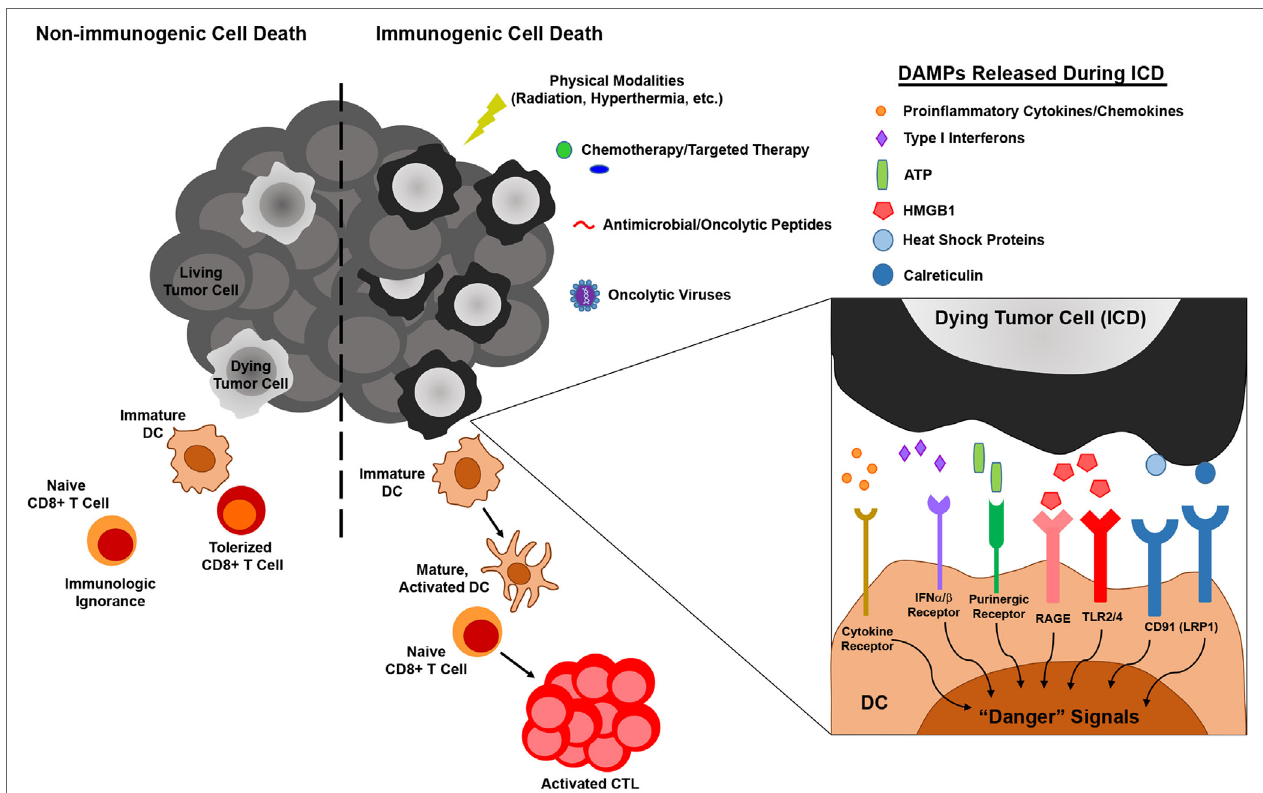
FiGURe 1 | The influence of immunogenic versus non-immunogenic tumor cell death on dendritic cell (DC) maturation/activation and DC-mediated antitumor immunity. Non-immunogenic tumor cell death does not elicit DC maturation or activation, leaving DC in an immature state in which they either (1) fail to “sense” tumor cell death and therefore do not acquire tumor antigen (Ag) for presentation to naïve T lymphocytes or (2) acquire tumor Ag through phagocytosis and induce T cell tolerance. On the other hand, immunogenic tumor cell death, which can be elicited by various physical, chemical, and biological modalities, results in the release of damage-associated molecular patterns (DAMPs) that are recognized by pattern recognition receptors on DC, resulting in the delivery of “danger” signals that promote the maturation and activation of DC capable of stimulating antitumor T cell